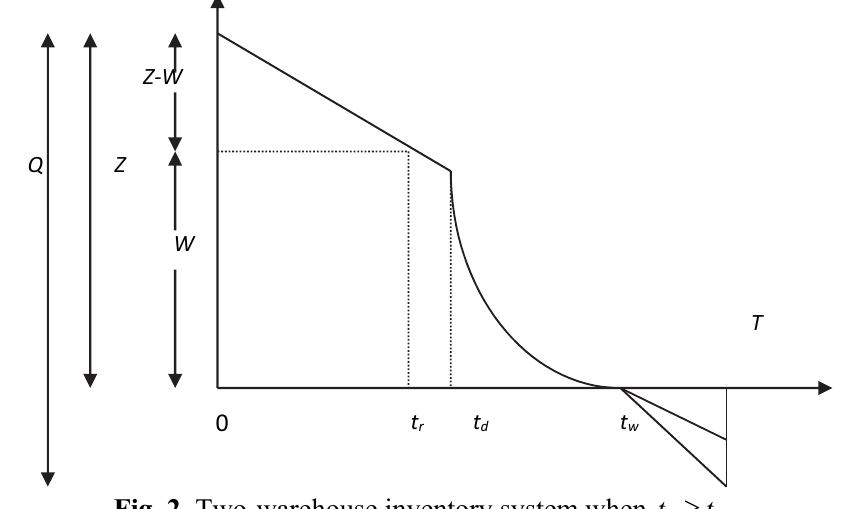
Fig. 2. Two-warehouse inventory system when